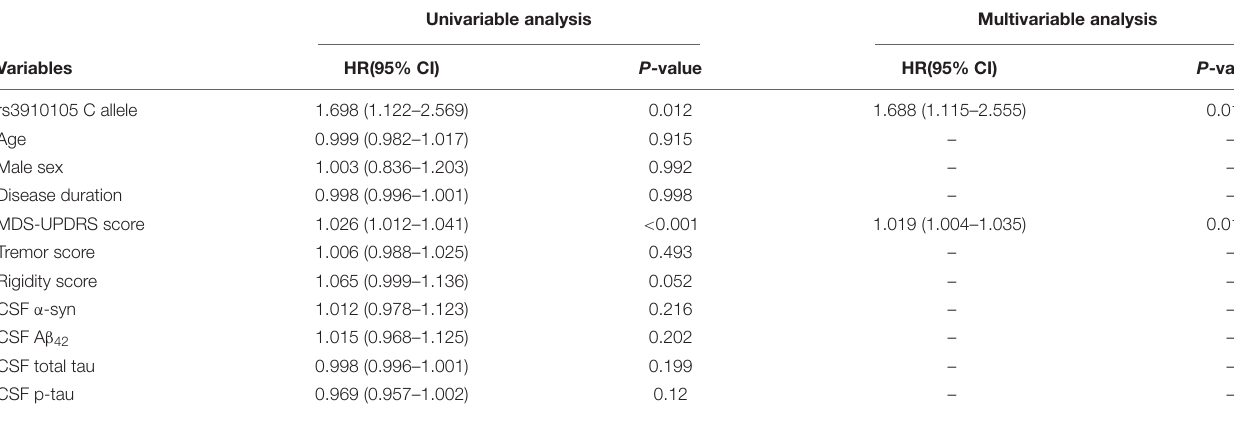
TABLE 3 | Results of the Cox regression analyses for the predictors of